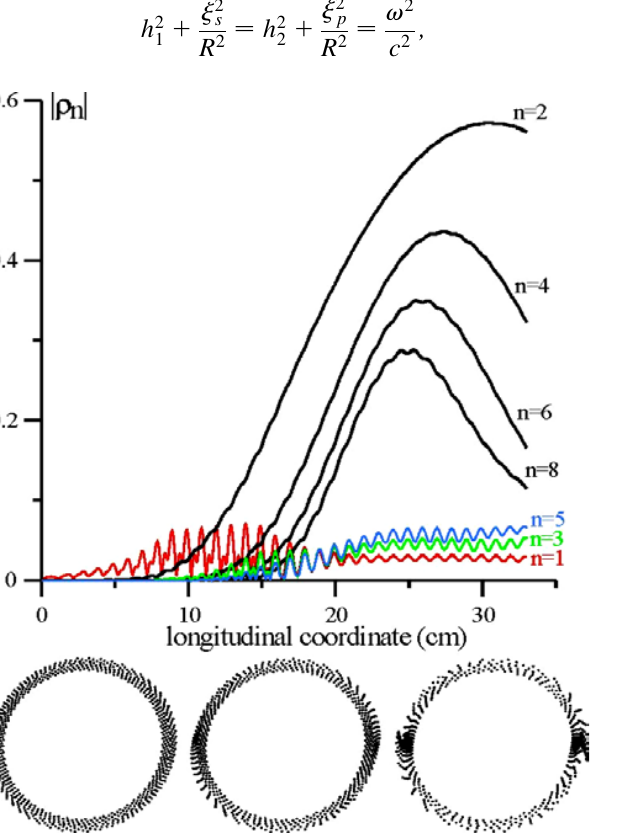
FIG. 6. (Color) Frequency tripling: operating (black curves) and spurious (color curves) harmonics of the electron current (cid:3) n versus the longitudinal coordinate and distribution of electrons over their gyrophases and Larmor radii for the case of 15% velocity